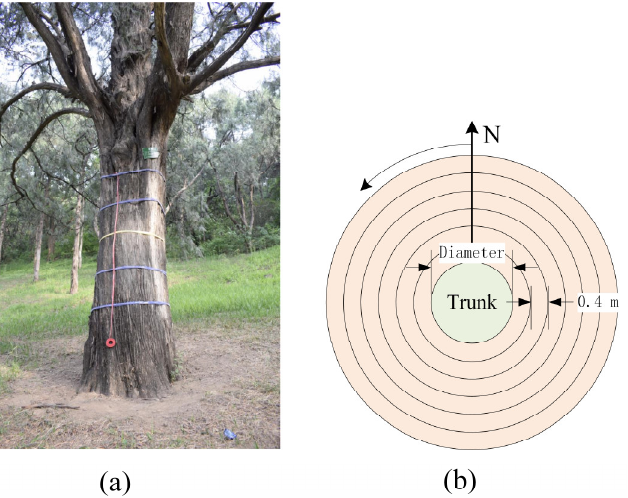
Figure 12. Detection tracks for each tree. ( a ) An example of a scanning tree (B00796). ( b ) The designed scanning tracks.